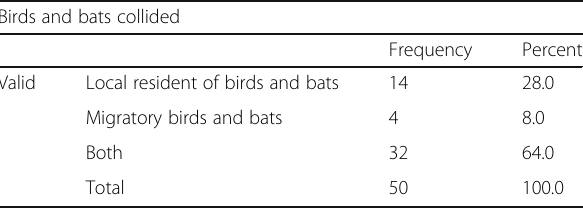
Table 1 Respondent reflection on the impact of birds and